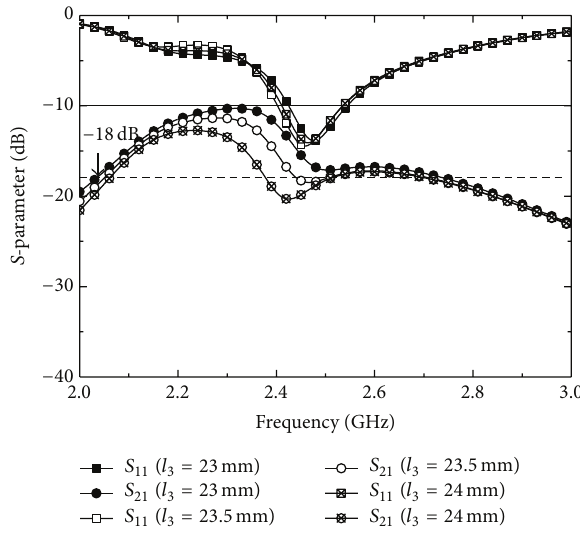
Figure 9: Simulated 𝑆 -parameter results for various values of length 𝑙